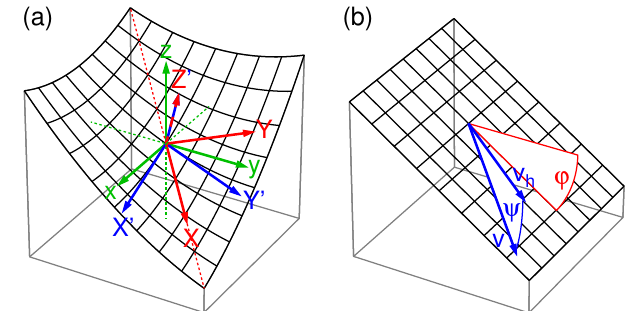
Figure 1. (a) Different coordinate systems used for modelling mass movements in a channel not parallel to any of the Cartesian coor- dinate axes. Green: Cartesian coordinates x , y , and z (this study). Blue: Coordinates aligned to the surface ( x (cid:48) and y (cid:48) parallel to the surface, z (cid:48) normal to the surface). Red: Coordinates aligned to the surface ( x , y , z ) where the x axis follows the thalweg (dashed red line). (b) Illustration of the slope angle ϕ of the fluid surface (Eq. 7) and the inclination angle ψ of the velocity (Eq.